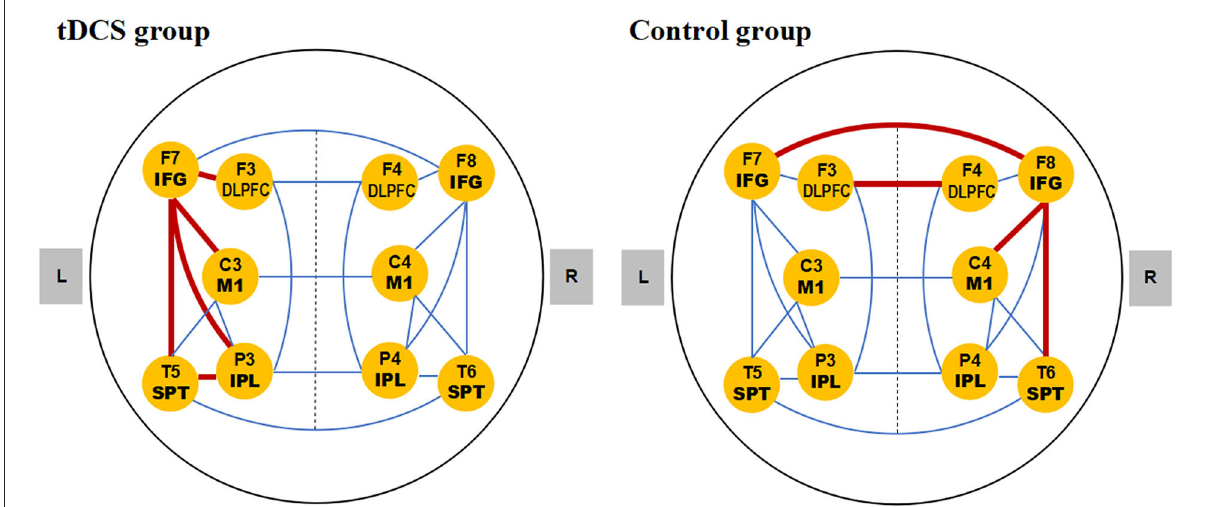
FIGURE3 The functional connectivity significantly activated in two groups. The lines indicated the C-ApEn within the left hemisphere, within the right hemisphere, and between hemispheres, illustrating the functional connectivity in the speech articulation network. The connectivity significantly activated in two groups (results in Table 5) was marked by red bold lines. DLPFC, dorsolateral prefrontal cortex; IFG, inferior frontal gyrus; IPL, inferior parietal lobe; M1, primary motor cortex; SPT, Sylvian-parietal-temporal region.